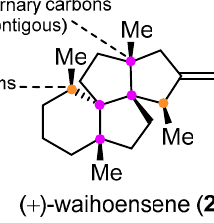
Figure 4. Structure of (+)-waihoensene ( 23 ).